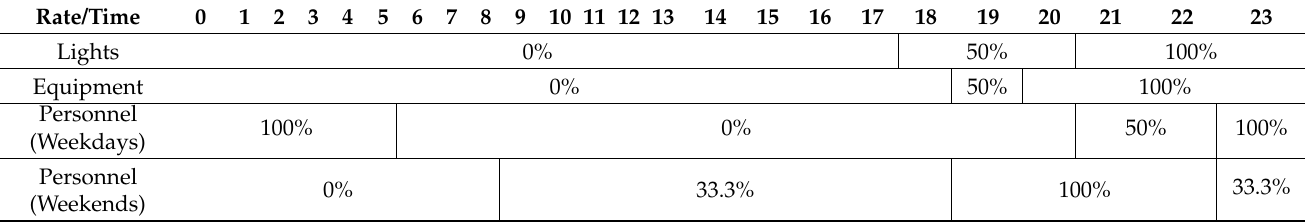
Table A3. The application rate of lights, equipment and personnel of bedroom and study at different times.